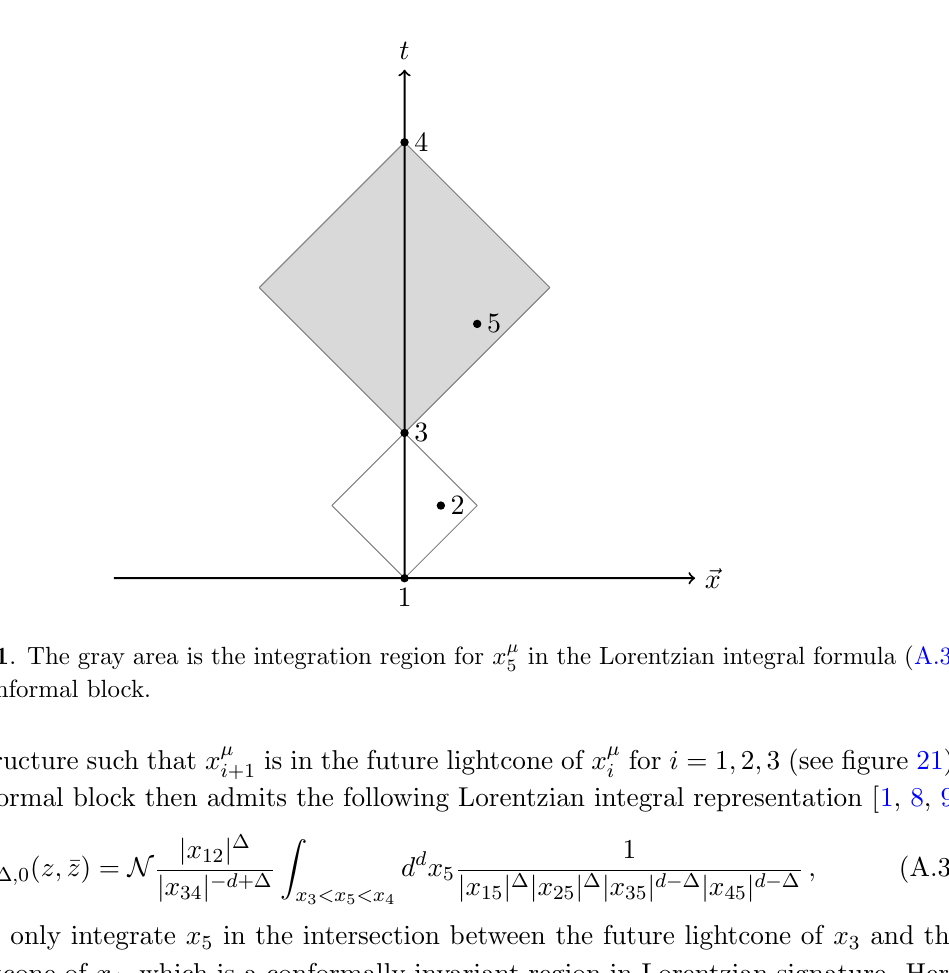
in the Lorentzian integral formula (A.3) 5